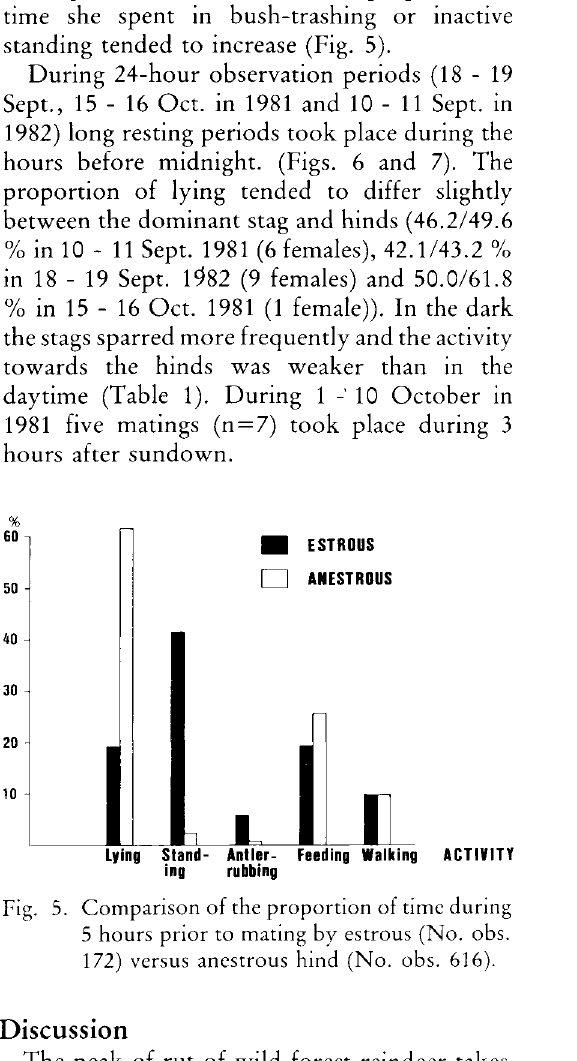
Fig. 4. Activity budget of anestrous hinds on their feet.